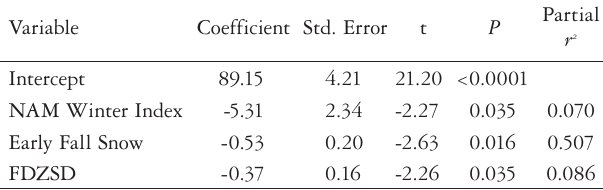
Table 2. Full stepwise regression results predicting Central Arctic Herd net productivity estimated ~1 week after the peak of calving based on the NAM winter index prior to calving, snowfall (cm) from 15 August–30 September of the previ- ous year, and the first day of zero snow depth in the spring (FDZSD; 10 May = 1), 1977–2002.